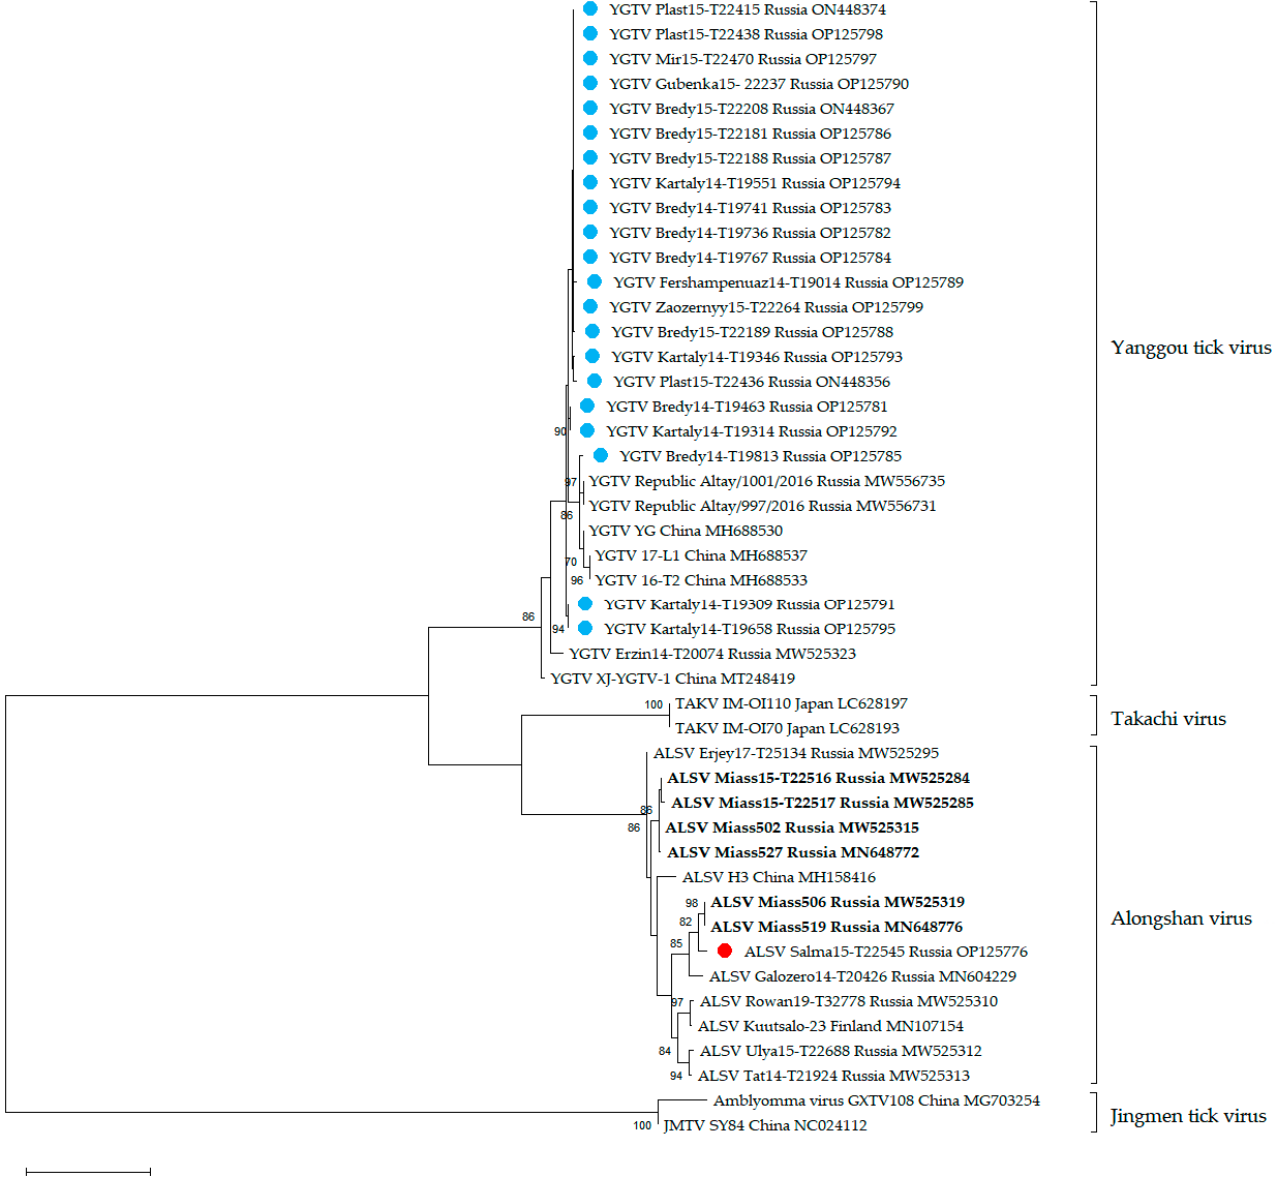
Figure 3. Phylogenetic analysis of flavi-like viruses. Phylogenetic trees were constructed using a fragment of segment 2 (296 bp) in MEGA X with the maximum likelihood method (1000 bootstrap replications). Bootstrap values (>70%) are shown at the branches. GenBank accession numbers are listed for each entry. Blue circles—strains of the Yanggou tick virus (YGTV) from the Chelyabinsk region de- scribed in this study. Red circles—strains of the Alongshan virus (ALSV) from the Chelyabinsk region described in this study. Bold font—ALSV strains from the Chelyabinsk region described